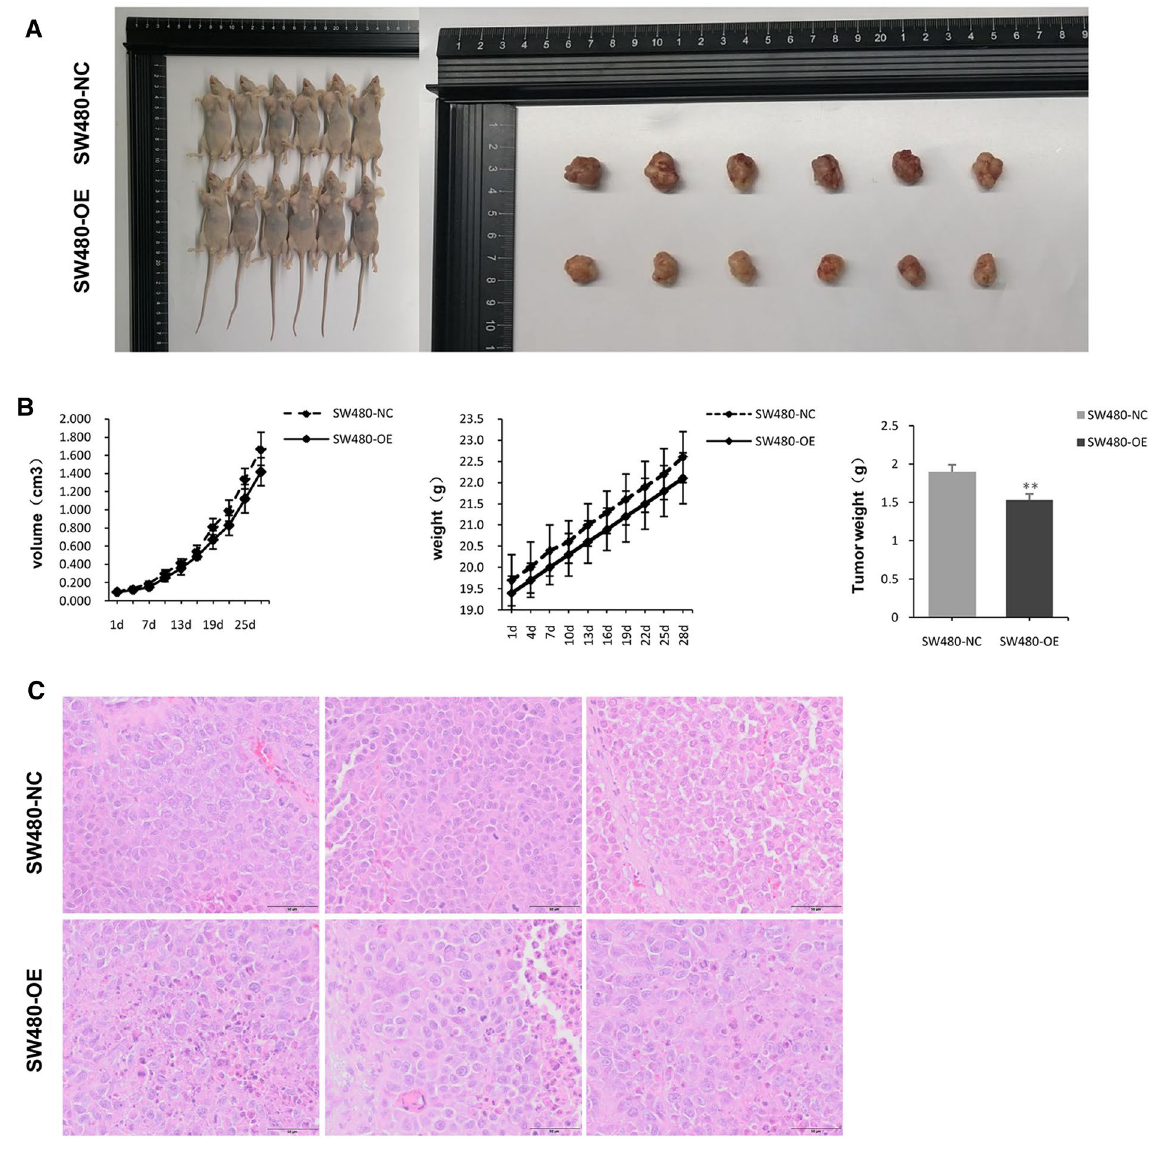
Fig. 4 ORF3a inhibited tumor growth and promoted tumor death. A , B Comparison of tumor volume, body weight, and tumor weight between the control group and the ORF3a high expression group. B Comparison of tumor histological morphology between the control group and the ORF3a high expression group. C Comparison of tumor tissues between the control group and the ORF3a high expression